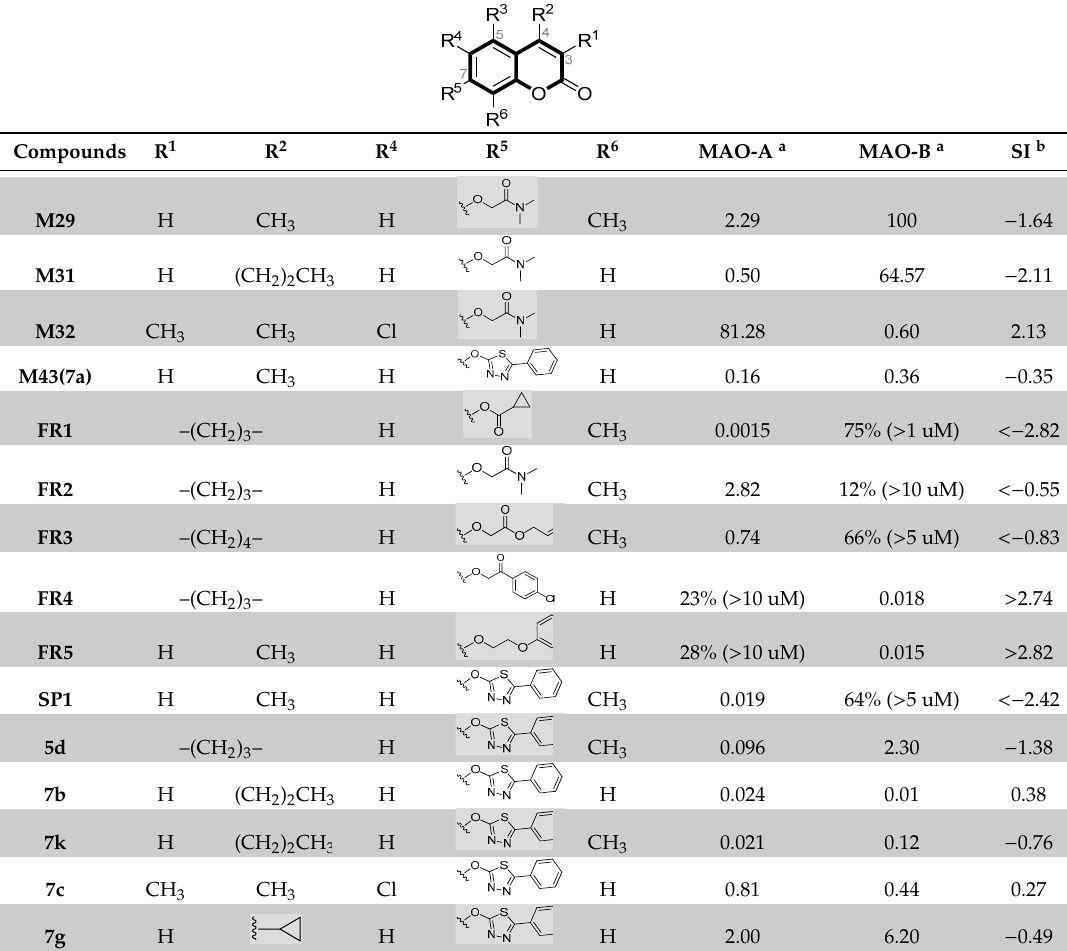
Figure 4. Strategy for the purchase or synthesis of C7 substituted coumarin analogues. Table 4. In vitro activities against h MAO subtypes of coumarin derivatives.